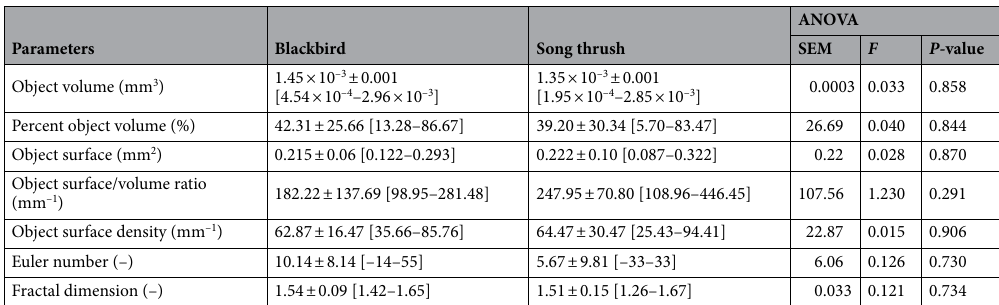
Table 2. 3D microstructure parameters of blackbird and song thrush eggshell.